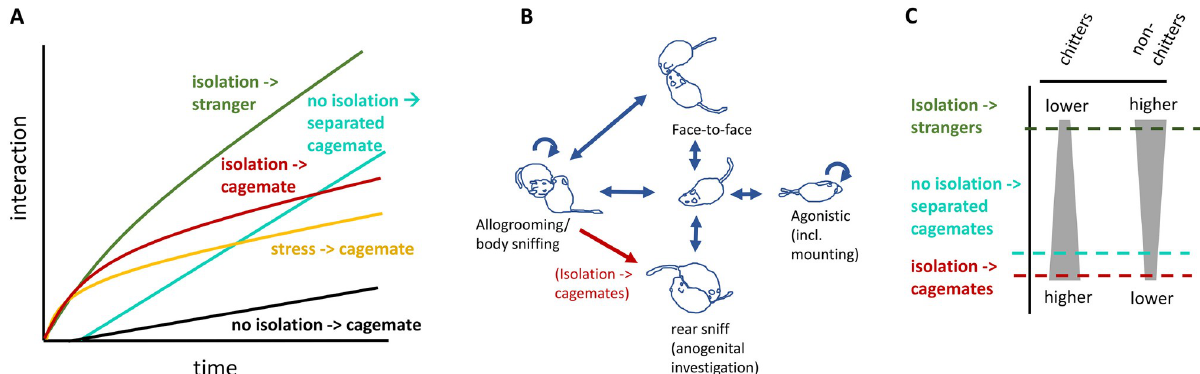
Fig 5. Overview of observed differences between conditions. A) Amount of interaction over time (stylized illustration based on data). Both social isolation and footshock stress resulted in higher early-session interaction, while reunions with strangers and previously separated cagemates led to increased interaction over a more prolonged time period. B) Illustration of significant transitions between interaction types. An increase in allogrooming before rear-sniffing was primarily observed only in cagemates after isolation. C) General differences in vocalizing between groups. Strangers showed highest levels of vocalizations but these were primarily across non-chitters, while the chitter syllable rate in cagemates was very high. Non-isolated, previously separated cagemates showed slightly more resemblance to strangers.